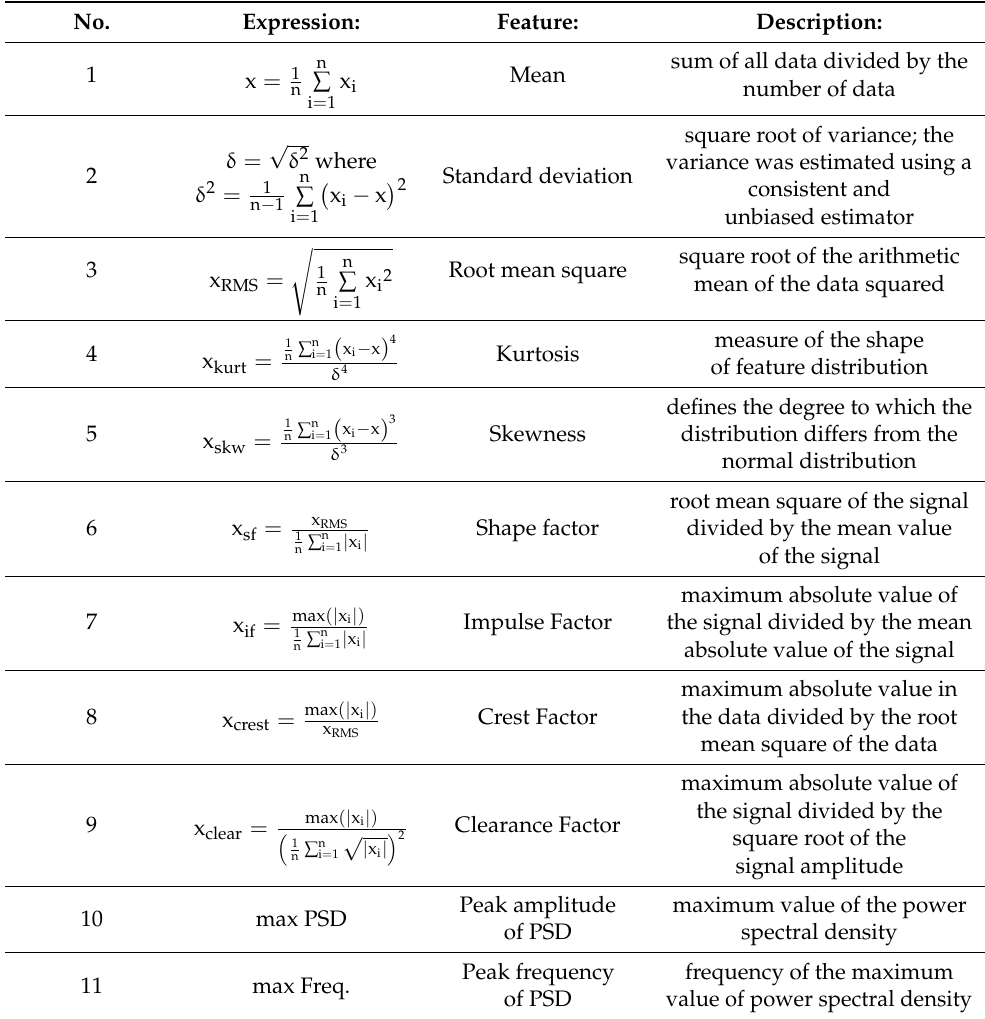
Table 1. List of features of the measured signals.